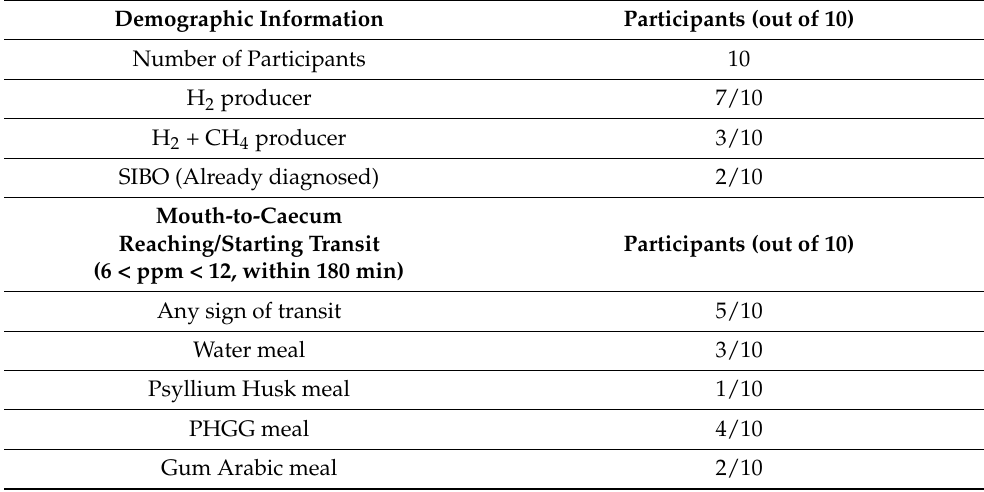
Table 4. General data produced by the breath test